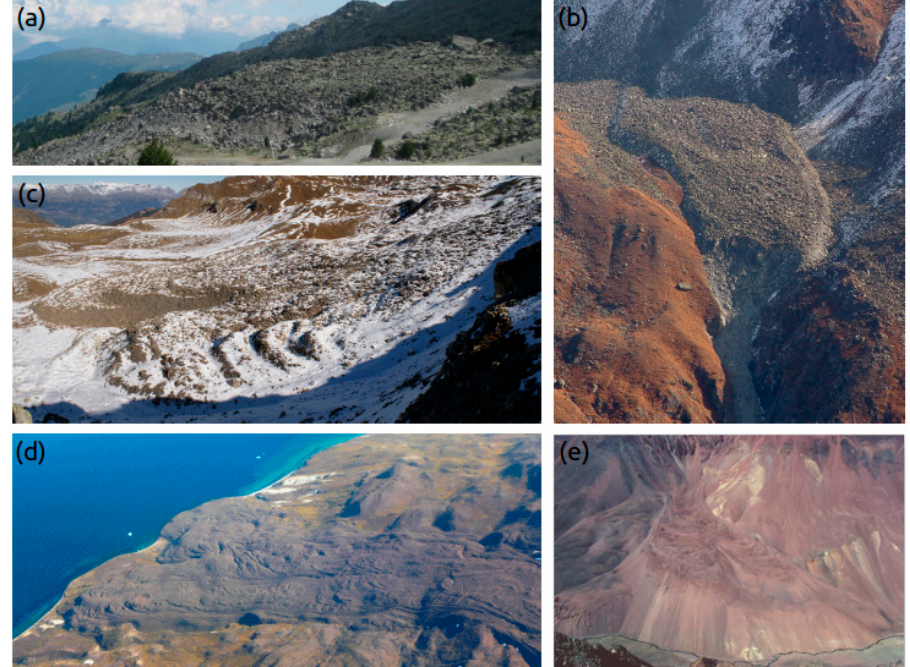
Figure 1. ( a ) Distelhorn rock glacier, Mattertal (Switzerland, 7°52’ E 46°11’ N). Photo, J. Papke (2012); ( b ) Tsarmine rock glacier, Val d’Arolla (Switzerland, 7°30’ E 46°03’ N). Photo, S. Morand (2005); ( c ) Becs-de-Besson rock glacier, Val de Réchy (Switzerland, 7°31’ E 46°10’ N). Photo, R. Delaloye (2011); ( d ) Manissuarsuk rock glacier, Qeqertarsuaq (Western Greenland, 52°37’ W 69°53’ N). Photo, E. Mätzler (2009); ( e ) Dos Lenguas rock glacier, Andes (Argentina, 69°47’ W 30°15’ S). Photo, L. Schrott (1991).